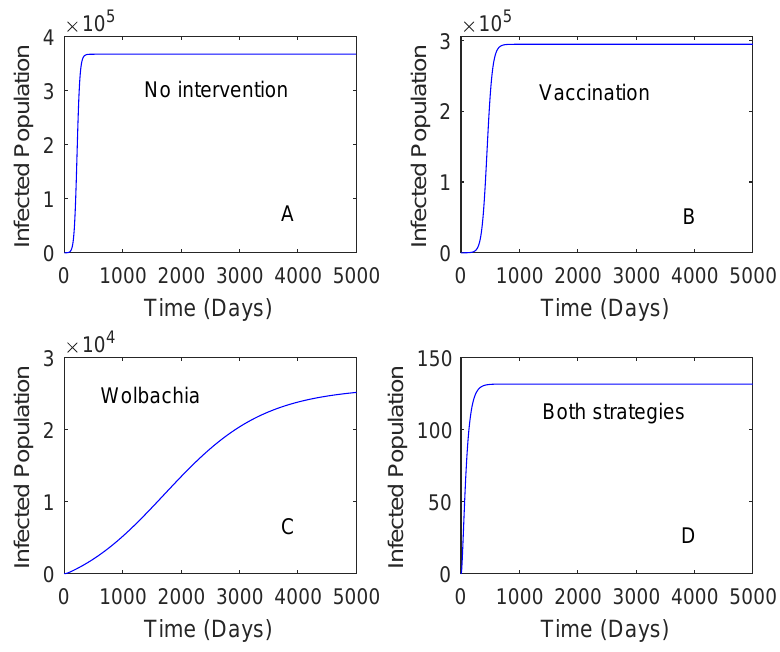
Figure 2. Numerical simulations of the model with no intervention, vaccine only, Wolbachia only, and both vaccine and Wolbachia . This is for the case R A = 2.91. The vaccine efficacy is 0.536 and the vaccination rate is 0.2. Plot ( A ): No intervention, Plot ( B ): Vaccination, Plot ( C ): Wolbachia , Plot ( D ): Both Wolbachia and vaccination